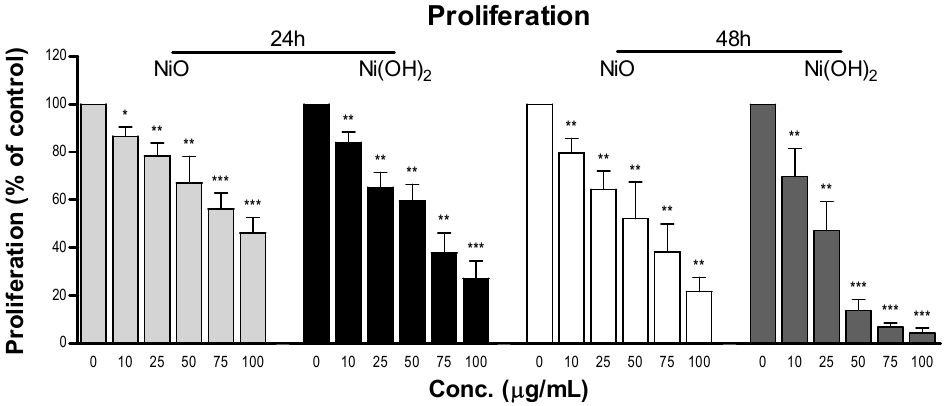
Figure 9. Inhibition of proliferation of A549 cells upon exposure to various concentrations of NiO or Ni(OH) 2 for 24 and 48 h. Unexposed cells were normalized to 100% proliferative and exposed cells were the percentage of proliferating cells compared to the control, * p < 0.05, ** p < 0.01, *** p < 0.0001 vs. control using a one-tailed, unpaired t -test. Values are expressed as the mean ± SD from four independent experiments.